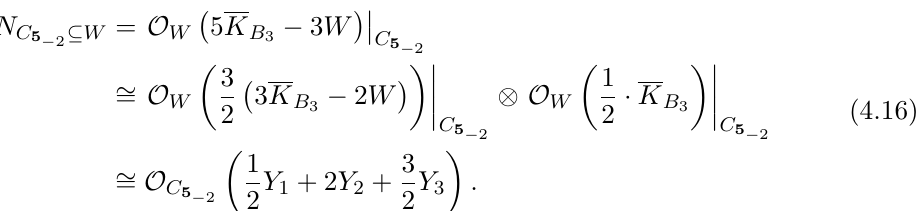
Figure 2. Schematic picture of the intersection properties of the matter curves C 10 and C 1 in the base space B 3 . We indicate the self-intersection numbers of the matter curves in W 5 by the tiny coloured numbers attached to Y i . The outer box is to represent the base space B 3